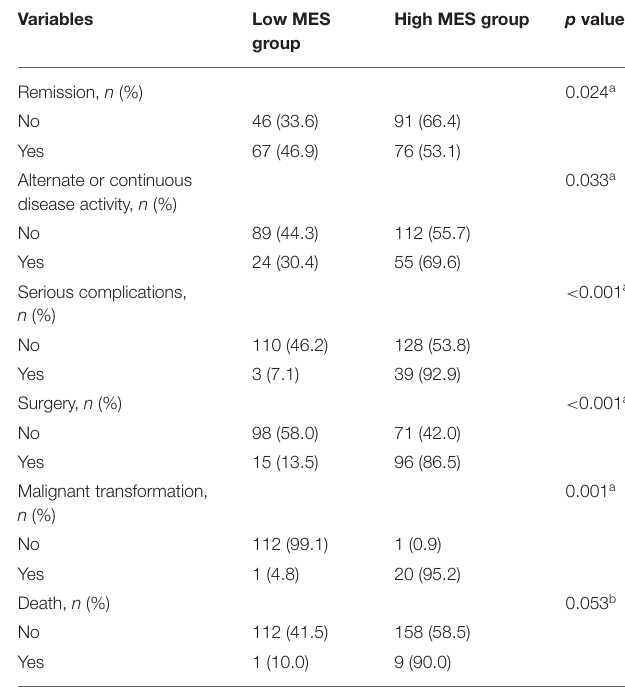
TABLE 1 | Main baseline characteristics of patients. Variables